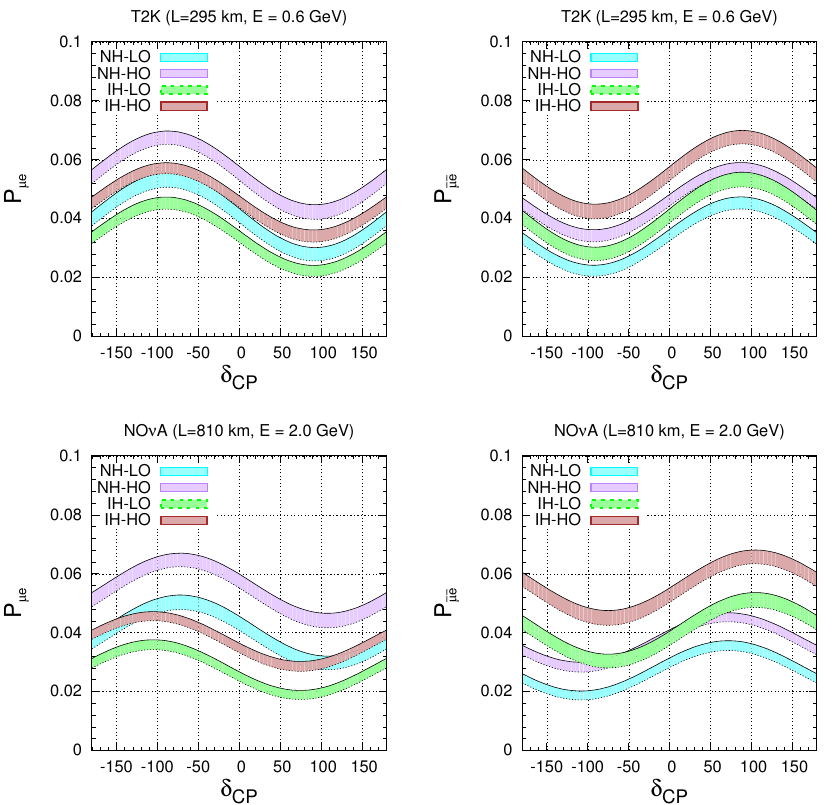
Figure 1 . Probability vs. (cid:14) CP for T2K & NO (cid:23) A. The bands are obtained by varying (cid:18) 23 in lower octant and upper octant. See text for